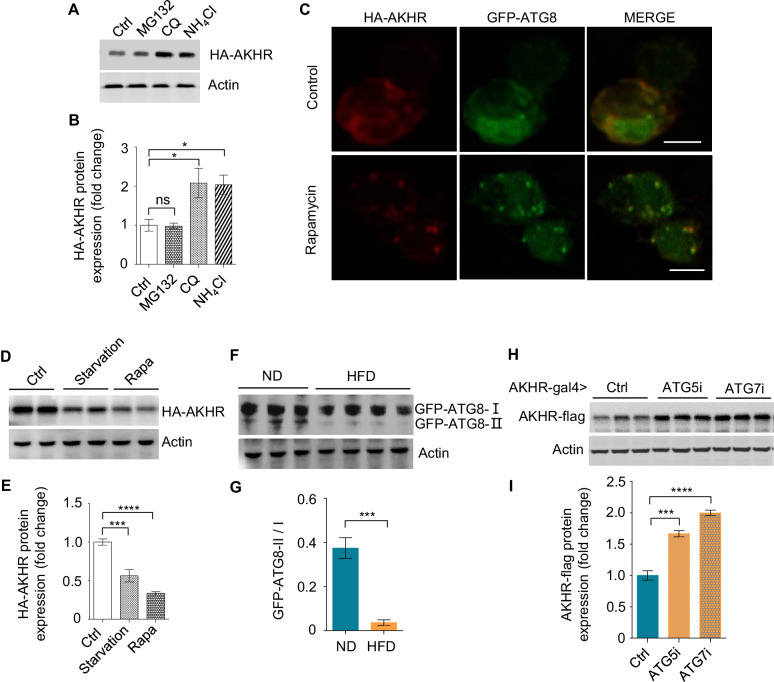
AKHR accumulation is induced by the suppression of autophagy.(A–B) Quantification of AKHR protein levels in cultured Drosophila S2 cells upon the treatment of proteasome and lysosome inhibitors (n = 3 biological replicates). Cultured cells transiently expressing AKHR-HA were treated with the indicated chemicals. The lysates were analyzed by western blot with HA antibody (A) and quantified in (B). (C) Formation of autophagosome in cultured S2 cells. Cultured cells transiently expressing AKHR-HA and GFP-ATG8 were treated with 200 nM rapamycin for 12 hr and stained with HA antibody. (D–E) Quantification of AKHR protein levels in Cultured Drosophila S2 cells upon starvation and the treatment of rapamycin (n = 3 biological replicates). Cultured S2 cells transiently expressing AKHR-HA were starved or treated with rapamycin, and AKHR-HA was analyzed by western blot. (F–G) Quantification of ATG8 activation in the head tissues of flies in vivo (n = 3–4 biological replicates, each containing 25 flies). GFP-ATG8 was specifically expressed in AKHR+ neurons by using the GAL4-UAS system. Flies were fed with ND or HFD and their head tissues were collected for western blot with GFP antibody. The ratio between ATG8-II and ATG8-I bands indicates the level of autophagy. (H–I) Quantification of AKHR protein levels upon suppressing neuronal autophagy in AKHR+ neurons in vivo (n = 3 biological replicates,, each containing 25 flies). ATG5 and ATG7 were knocked down by the expression of RNAi constructs in AKHR+ neurons. AKHR-flag expression was assayed by western blot. ns, p>0.05; *p<0.05; **p<0.01; ****p<0.0001. Student’s t-test and one-way ANOVA followed by post hoc test with Bonferroni correction were used for pair-wise and multiple comparisons, respectively.